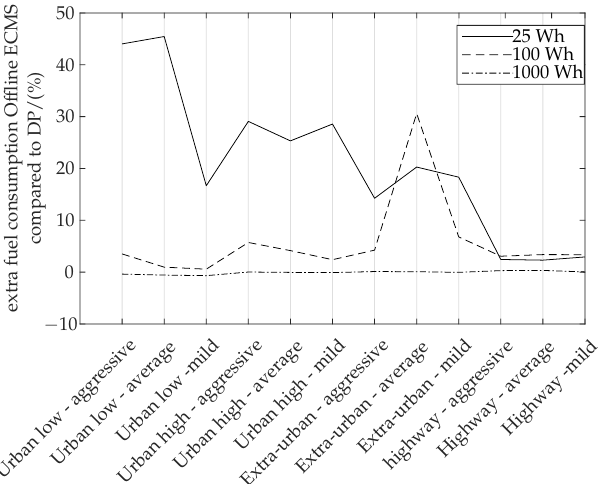
Figure 4. Comparing Offline ECMS and DP to calculate the global optimum (fuel consumption) for different battery capacities: extra fuel consumption of an Offline ECMS when limiting battery capacity to 25 Wh, 100 Wh, and 1000